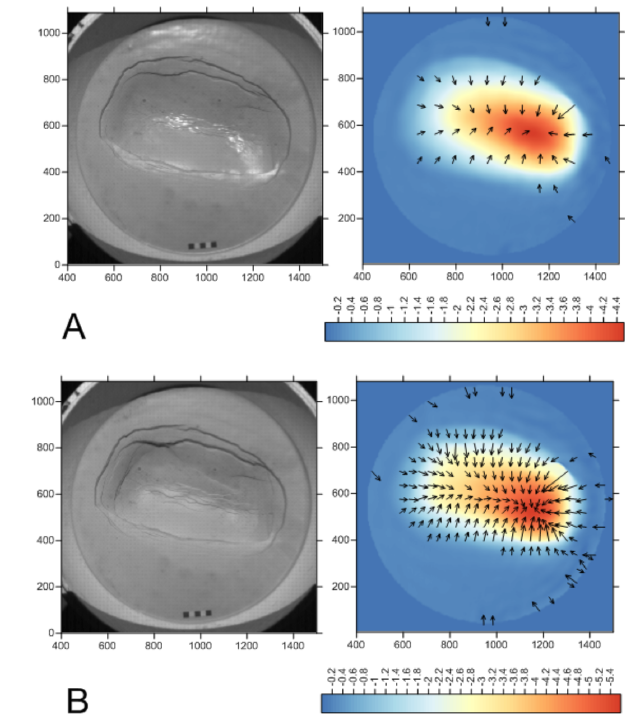
Figure 7. Interferometry analysis of selected photographs from Fig. 6 (c – growing of faults and d – dessication). (a) DEM of the image at the moment when the water level reached the bottom of the crater, color scale represent the subsidence in centimeters and the arrows indicate the magnitud and direction of the slope, the in- plane scale is in pixels. (b) DEM of the image at a later desiccation time and deformation (color scale and arrows as above), note that the development of faulting has an effect in